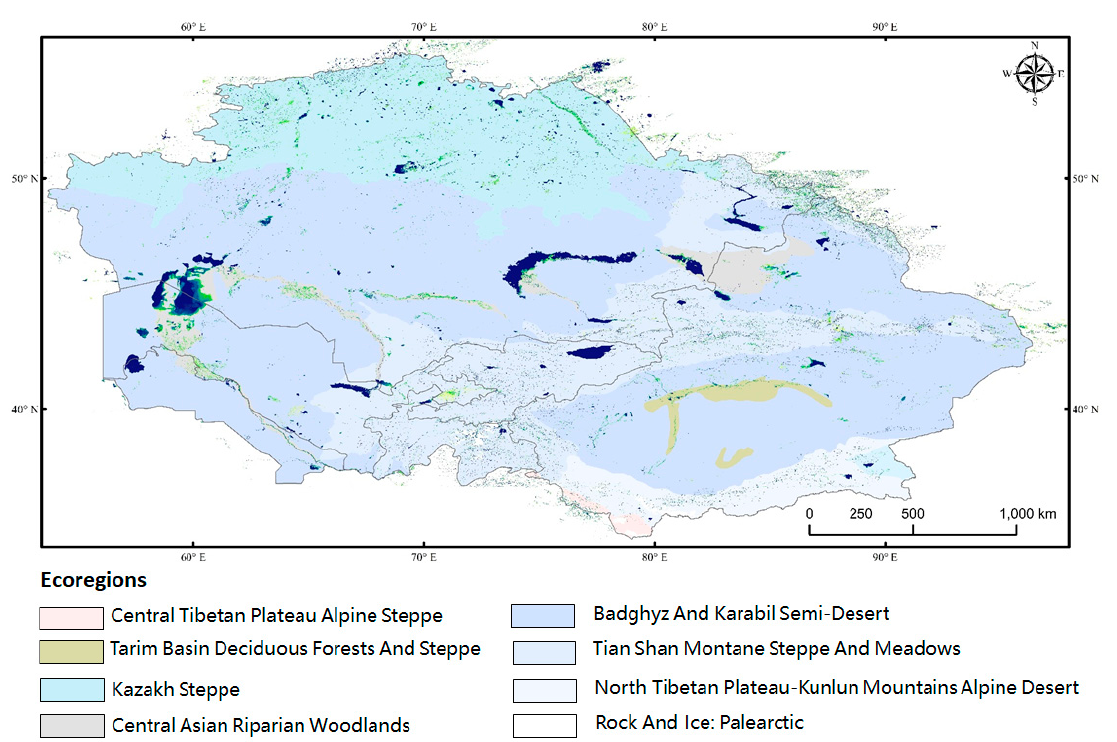
Figure 7. WOF distribution overlaid by eight terrestrial ecological zones in the arid and semi-arid regions of central Asia.